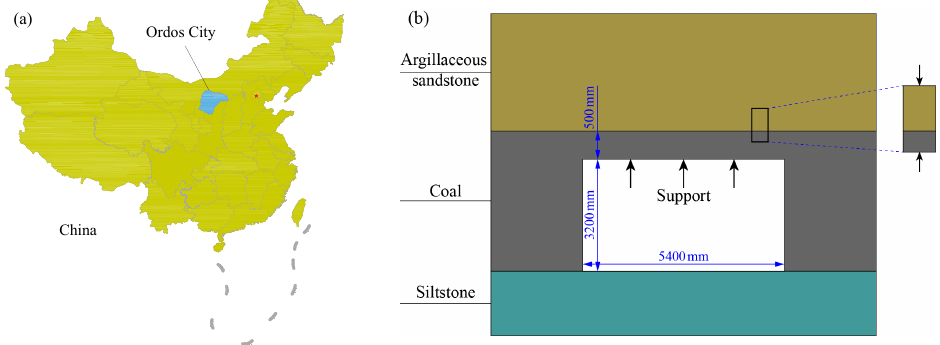
Figure 1. Geographic location of Ordos City and schematic diagram of test roadway: ( a ) geographic location of Ordos City; ( b ) schematic diagram of test roadway.